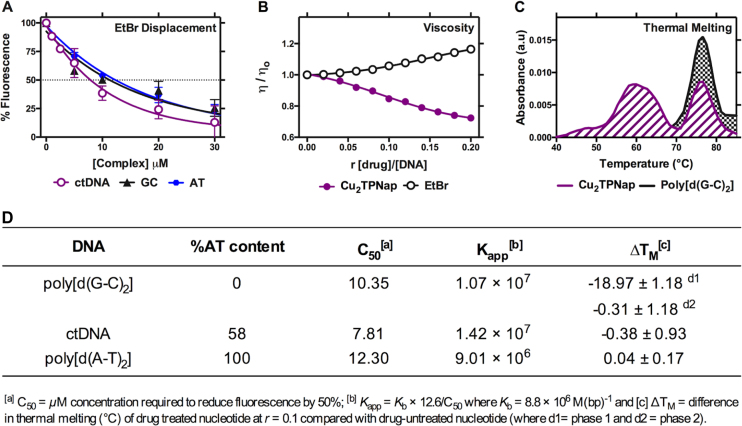
(A) Binding of Cu2TPNap complex to ethidium-saturated solutions of dsDNA (ctDNA, poly[d(A-T)2] and poly[d(G-C)2]); (B) viscosity profile of complex treated and EtBr treated salmon testes dsDNA; (C) thermal melting profile of untreated poly[d(G-C)2] nucleotide and complex treated nucleotide at r = 0.1; and (D) apparent DNA binding constants (Kapp) and influence on thermal denaturation of Cu2TPNap.